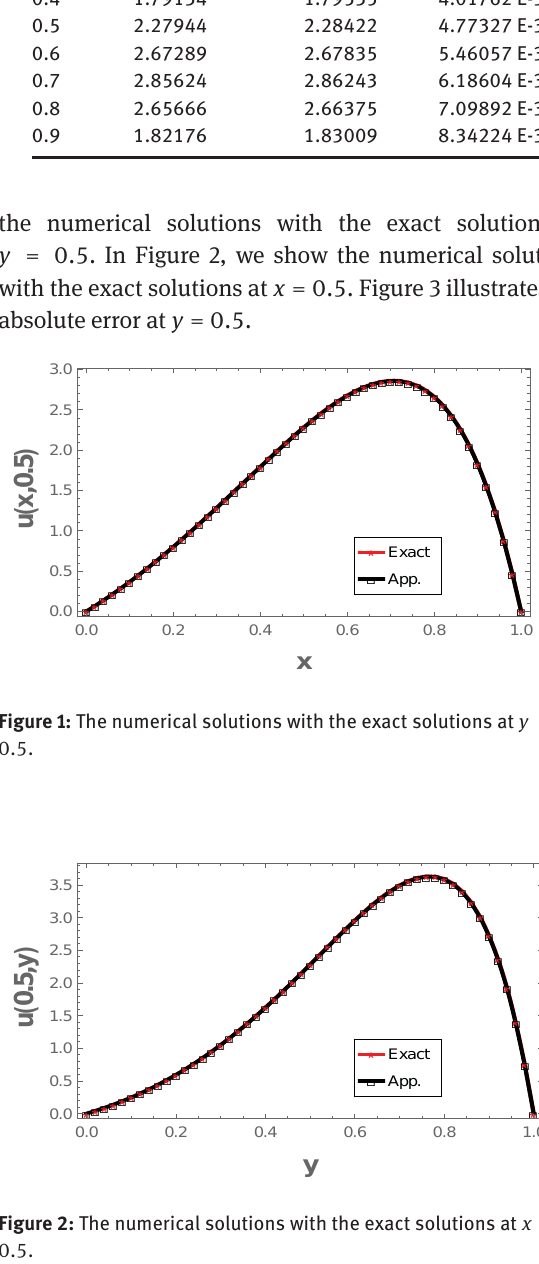
The second problem: MHD duct flow [12–14,